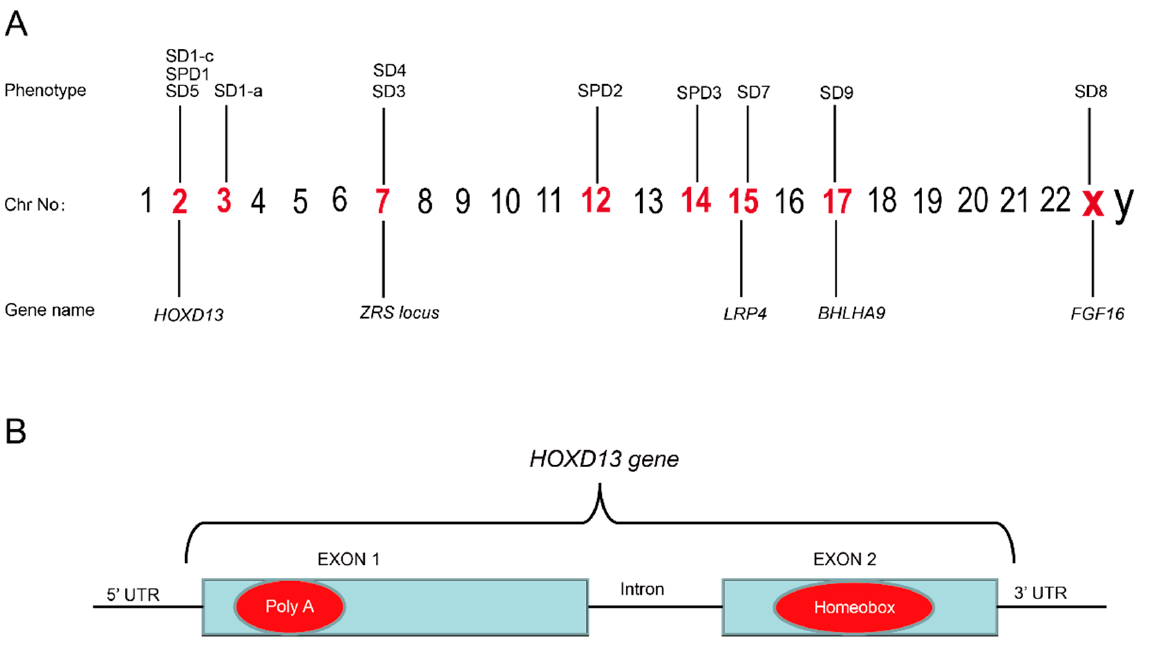
Figure 3. ( A ) Illustration of chromosomes and the syndactyly types belonging to different chromosomes. ( B ) The mutational hot spots in the poly(A) region in exon 1 and homeobox region in exon 2 of the HOXD13 gene are marked in red.